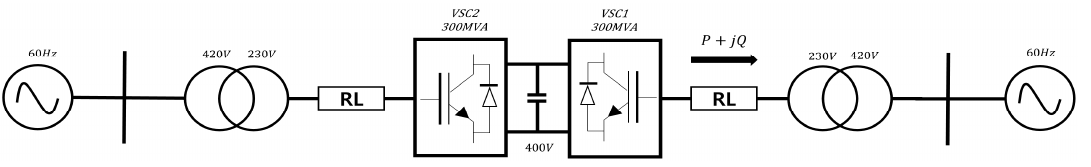
Figure 9. Single-line diagram of the test BTB VSC-HVDC system.